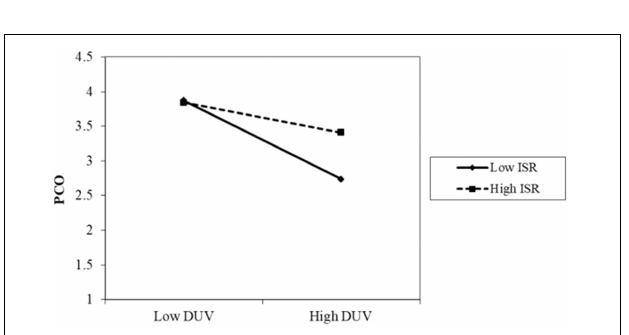
FIGURE 4 | Moderating effect of ISR. ISR, industry self-regulation; DUV, data vulnerability; PCO, psychological